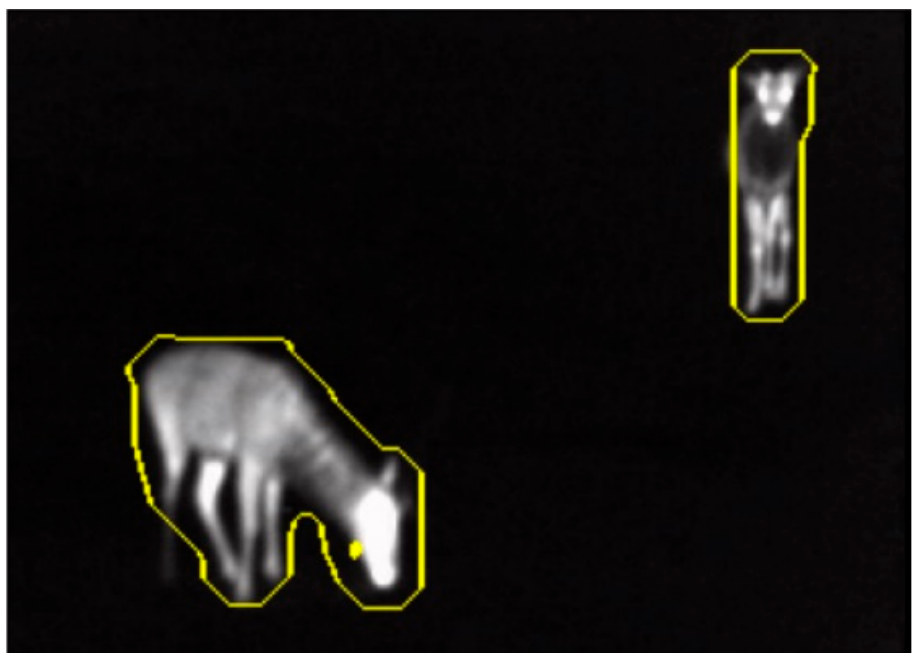
Figure 3. Region Proposal gained from Falzenszwalb’s algorithm.